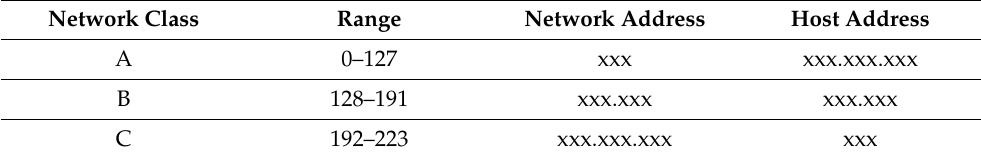
Table 3. The division and available numbers range of IP Addresses